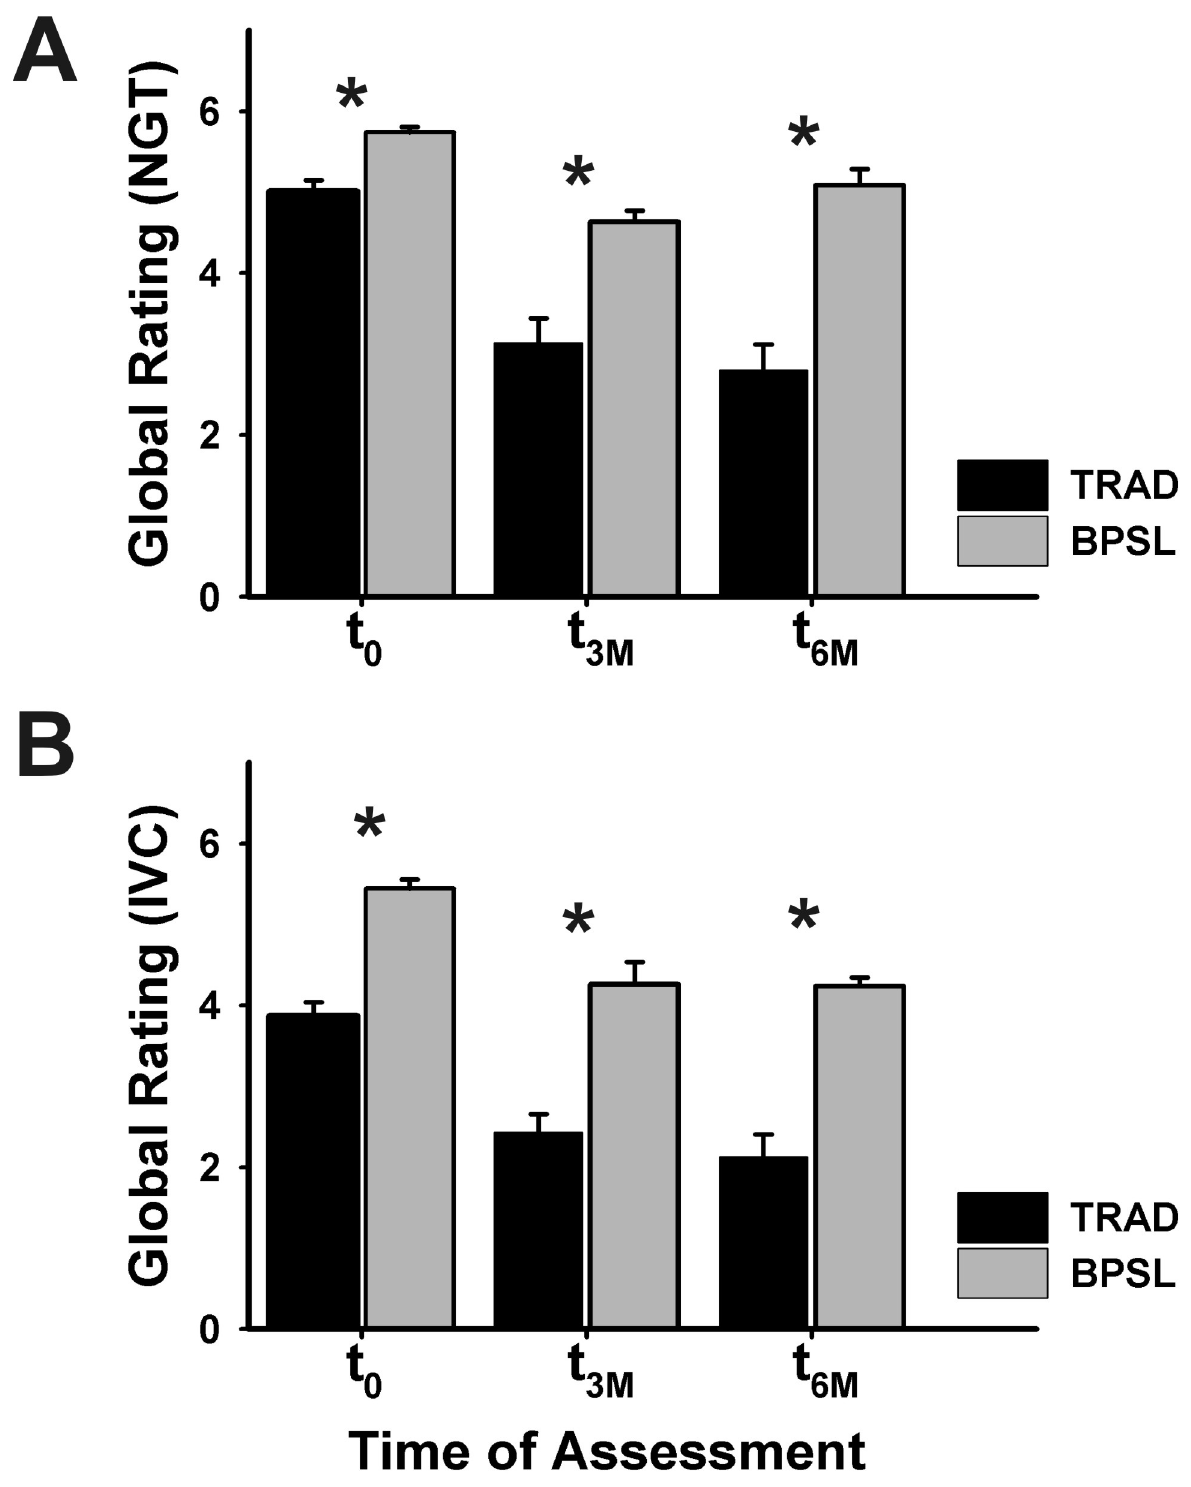
Figure 3. Single-item global rating of performance (mean + SEM) initially after training (t later, respectively. NGT = nasogastral tube insertion, IVC = intravenous cannulation, TRAD = traditional “see one, do one” training, BPSL = Best Practice Skills Lab Training. Significant differences (p<0.05) are marked with an asterisk.